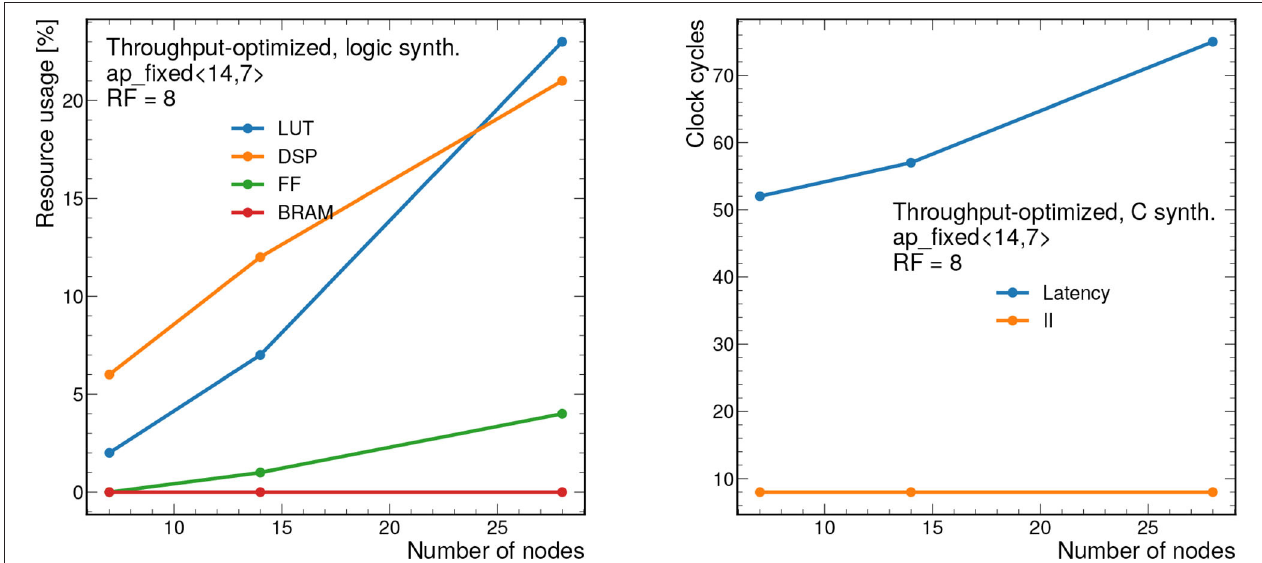
FIGURE 10 | Resource usage estimates as a percentage after logic synthesis (left) and latency and II in clock cycles (right) for a constant reuse factor of 8 and a bit width of ap_fixed<14,7> as a function of the number of nodes n nodes . The number of edges is fixed to n edges graphs. Each clock cycle corresponds to 5ns.